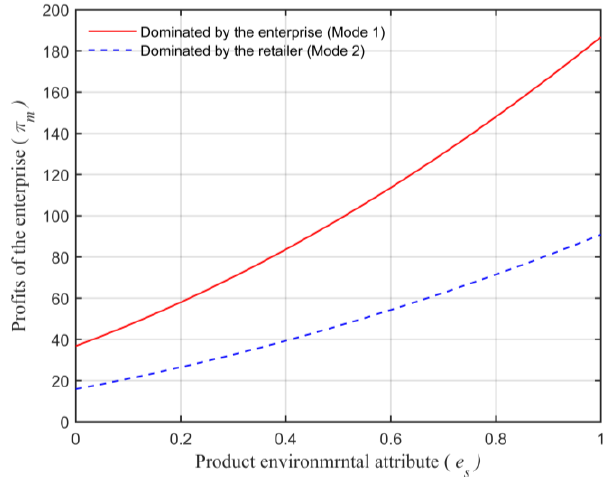
Figure 8. The relationship between the product environmental attribute and the marine ranching leading enterprise ’ s profits.